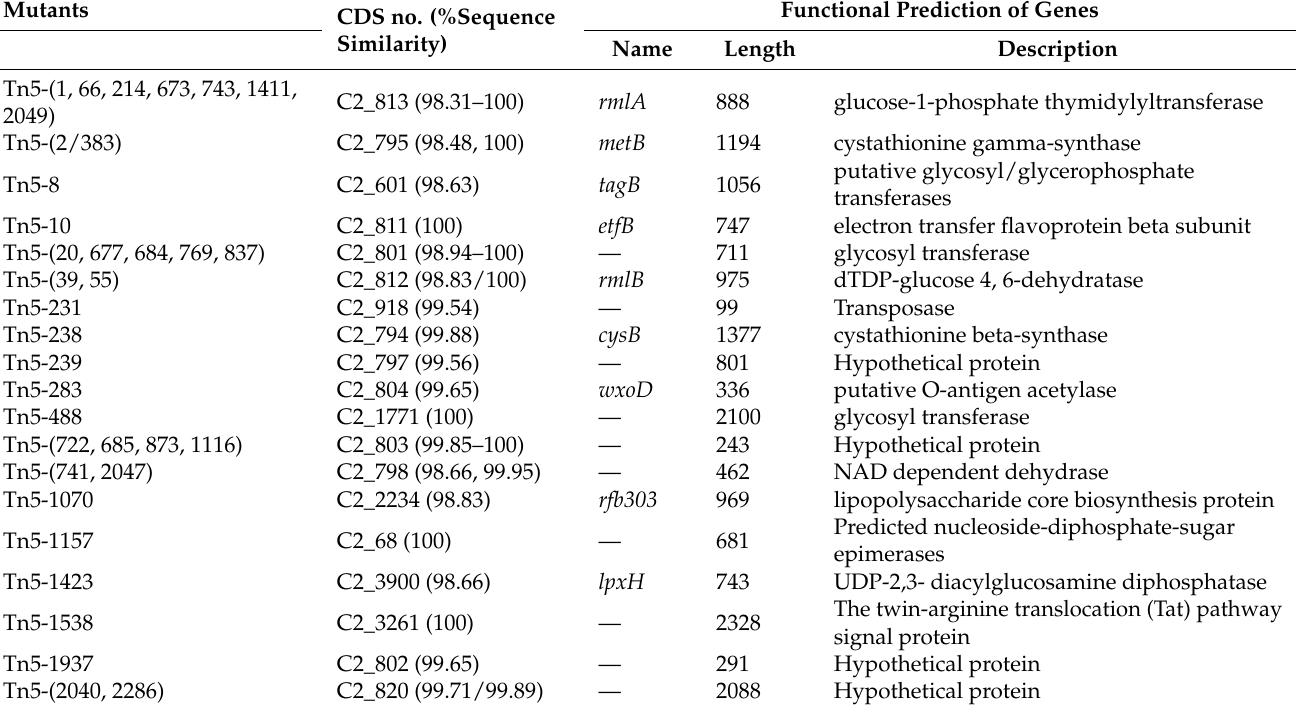
Table 1. Identification of the Tn5 insertion site by using reverse